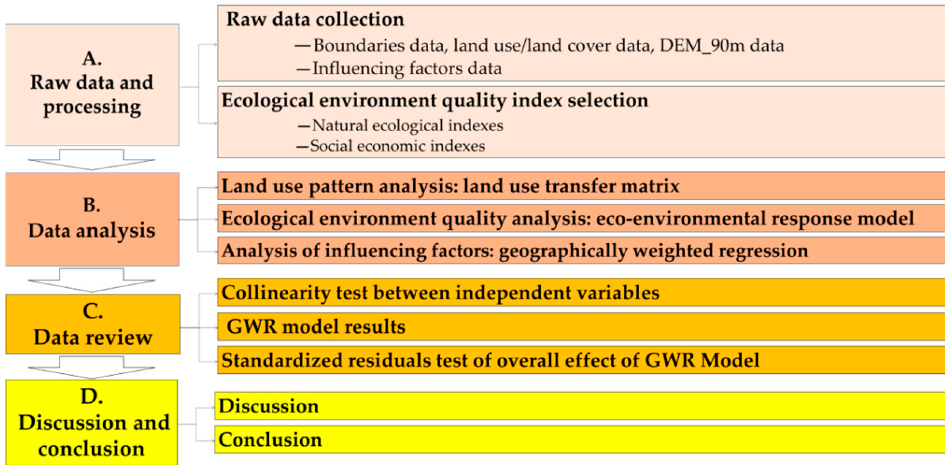
Figure 2. Research framework and steps. Table 3. Index selection and